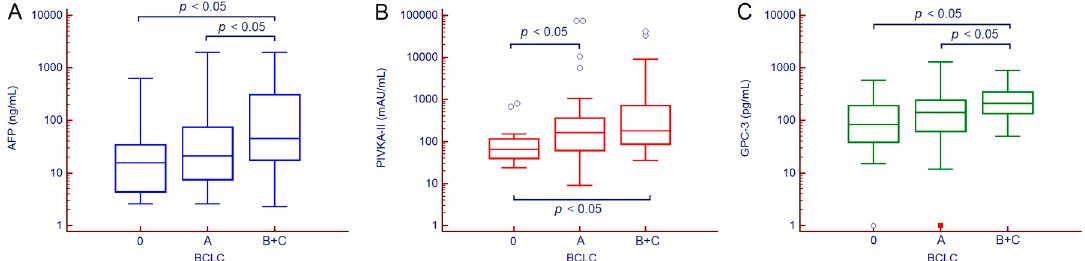
Figure 5. AFP ( A ), PIVKA-II ( B ) and GPC-3 ( C ) serum values in patients with HCC according to BCLC stage. Hollow circles indicate values that are smaller than the lower quartile minus 1.5 times the interquartile range, or larger than the upper quartile plus 1.5 times the interquartile range; red squares indicate values that are smaller than the lower quartile minus 3 times the interquartile range, or larger than the upper quartile plus 3 times the interquartile range. p values were calculated by Mann–